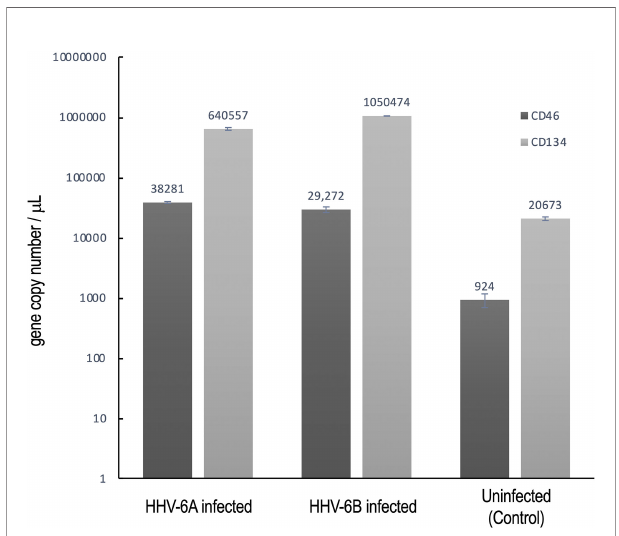
FIGURE 11 | CD134 and CD46 gene expression in HHV6 infected cells. Using RT-qPCR CD134 and CD46 mRNA expression was determined for dHNSC (i.e., H9 cells) after infection with either HHV-6A or HHV-6B and compared to uninfected controls. After 2 hr post-infection, CD134 (light grey) and CD46 (dark grey) mRNA levels were elevated when compared to uninfected control cultures (far right); (N=6, p=0.0002). CD134 expression levels are greater than CD46 in HHV-6A and HHV-6B infected cultures; (N=6, p=0.0013). CD134 expression is also greater in uninfected cells. These data indicate that cells express CD134 at higher levels and that infection results in overexpression of both CD46 and